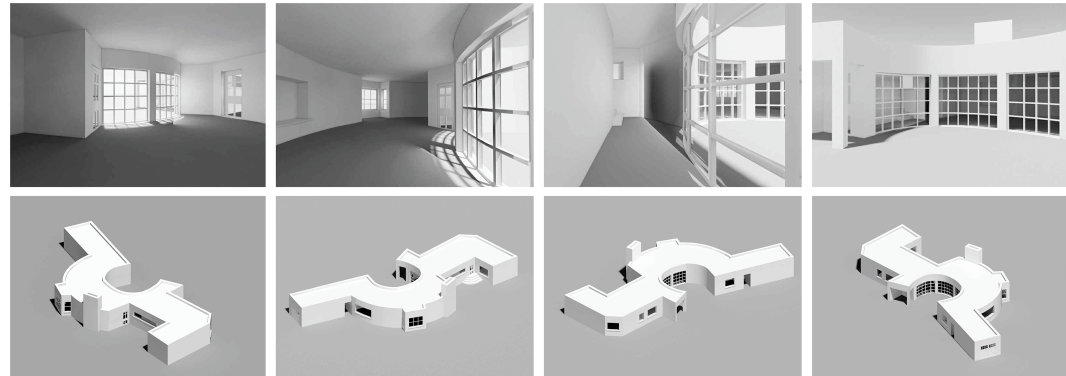
Figure 14. House 12. Axonometric views and perspectives (C.